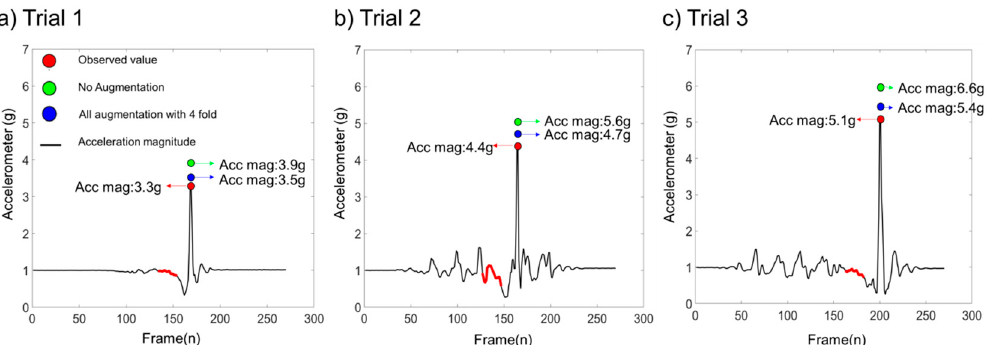
Figure 6. Pre-impact fall impact acceleration magnitude prediction at various levels of impact magnitude. ( a ) the impact acceleration magnitude prediction result for low level of impact; ( b ) the impact acceleration magnitude prediction result for mid-level of impact; ( c ) the impact acceleration magnitude prediction result for high level of impact